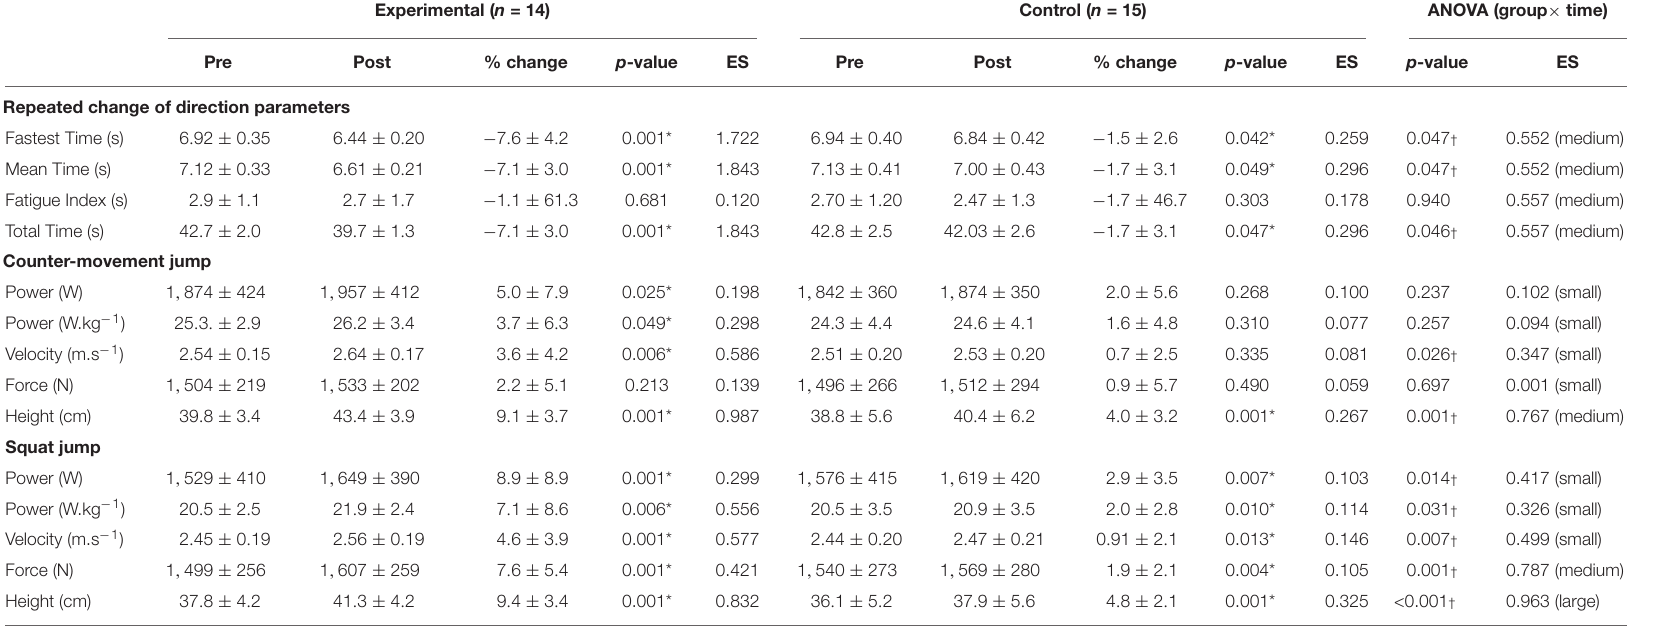
TABLE 6 | Repeated change of direction and vertical jump test performances in experimental and control groups before and after 8 week